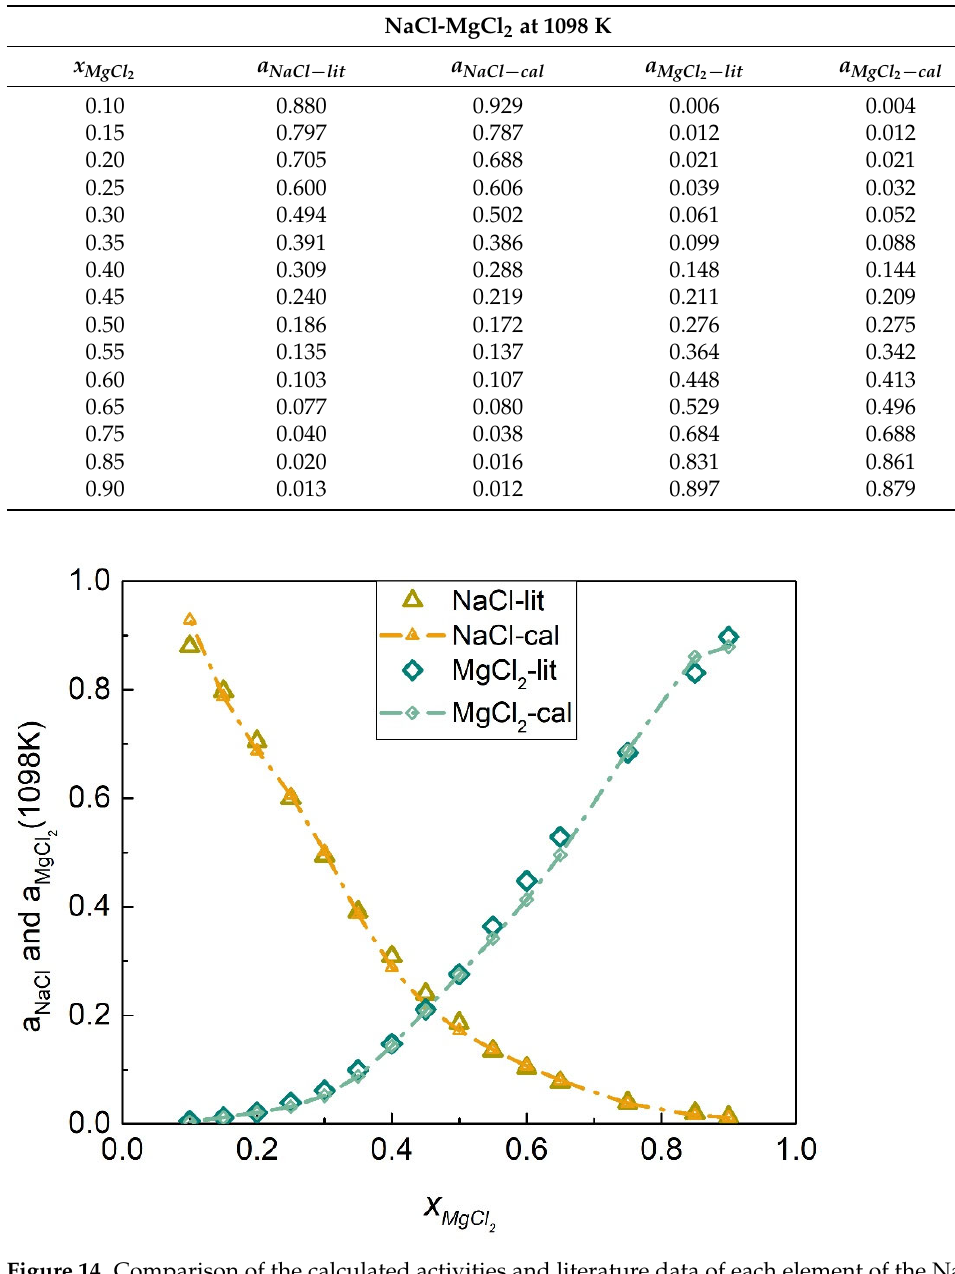
Figure 14. Comparison of the calculated activities and literature data of each element of the NaCl ‐ MgCl 2 system (1098 K).